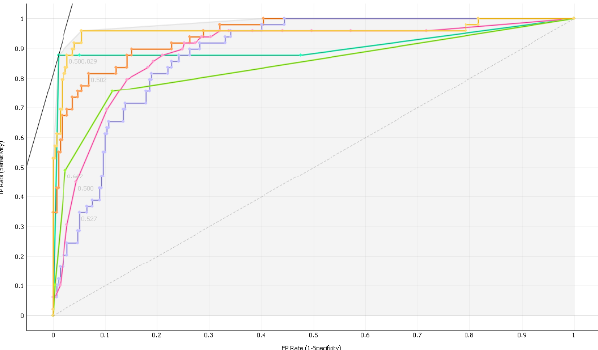
Fig. C1. ROC curve analysis relating to class “Good”